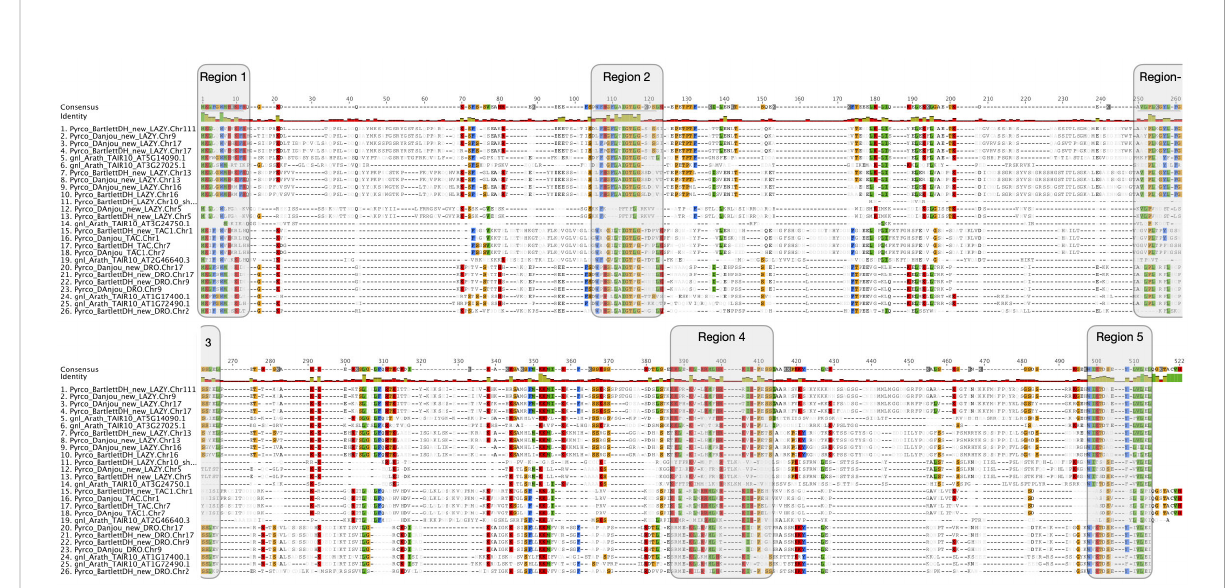
FIGURE 4 Amino acid comparison of IGT genes. Amino acid alignment of IGT genes from Arabidopsis thaliana , Bartlett.DH_v2, and d ’ Anjou. Sites consisting of a similar amino acid type as the consensus were highlighted with a background color following the Clustal color scheme in Geneious R9. Green color in the identity row indicates 100% identical across all sequences, greeny-brown color indicates identity from > 30% to < 100% identity, and red color indicates identity < 30%. Five conserved regions (domains) were highlighted with shaded boxes. Note: Region 3 is in both the upper and lower parts of the fi